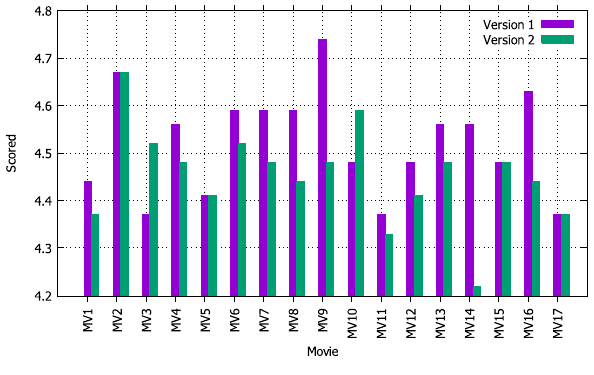
Fig. 8 User survey evaluation discover character relationships and the appearances of char- acters “on-screen” visually. Other techniques that should